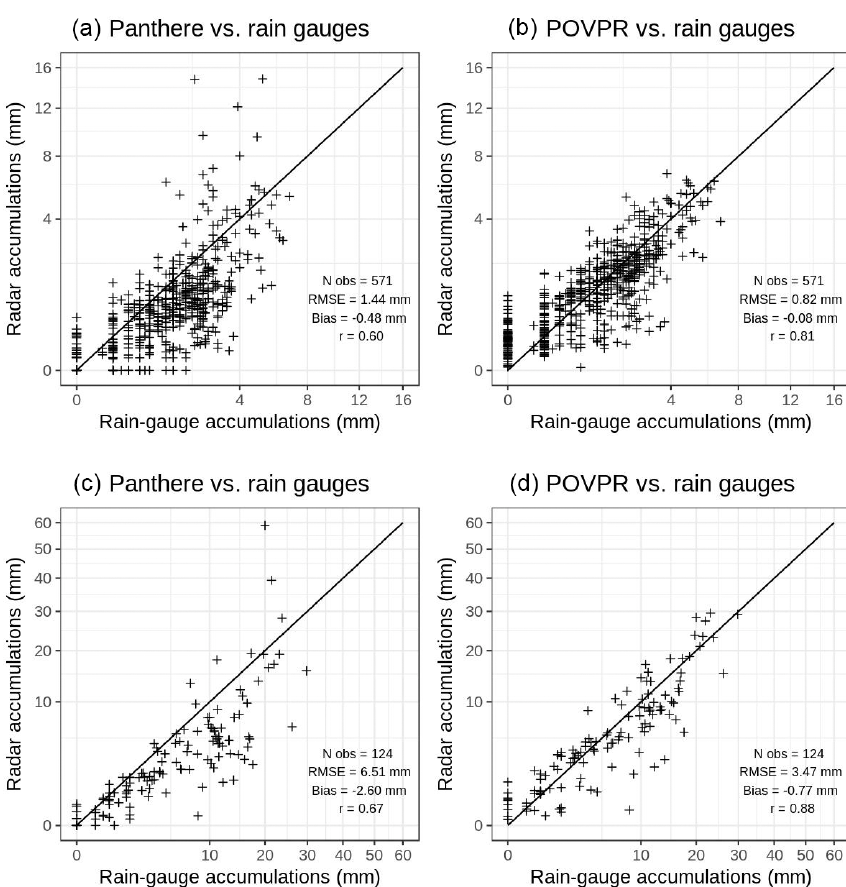
Figure 7. Comparisons between rain-gauge and radar accumulations computed for the 30 April 2018 event between 03:00 and 09:00UTC on the Abbeville radar domain. (a–b) Hourly accumulations; (c–d) 6h accumulations; (a–c) operational method Panthere; (b–d) POVPR method. The number of observations ( N obs ), the root mean square error (RMSE), the mean bias (Bias) and the Pearson correlation coefficient ( r ) are also displayed. Data in which the lowest valid radar elevation did not detect any precipitation (no precipitation or beam too high) were removed from the data